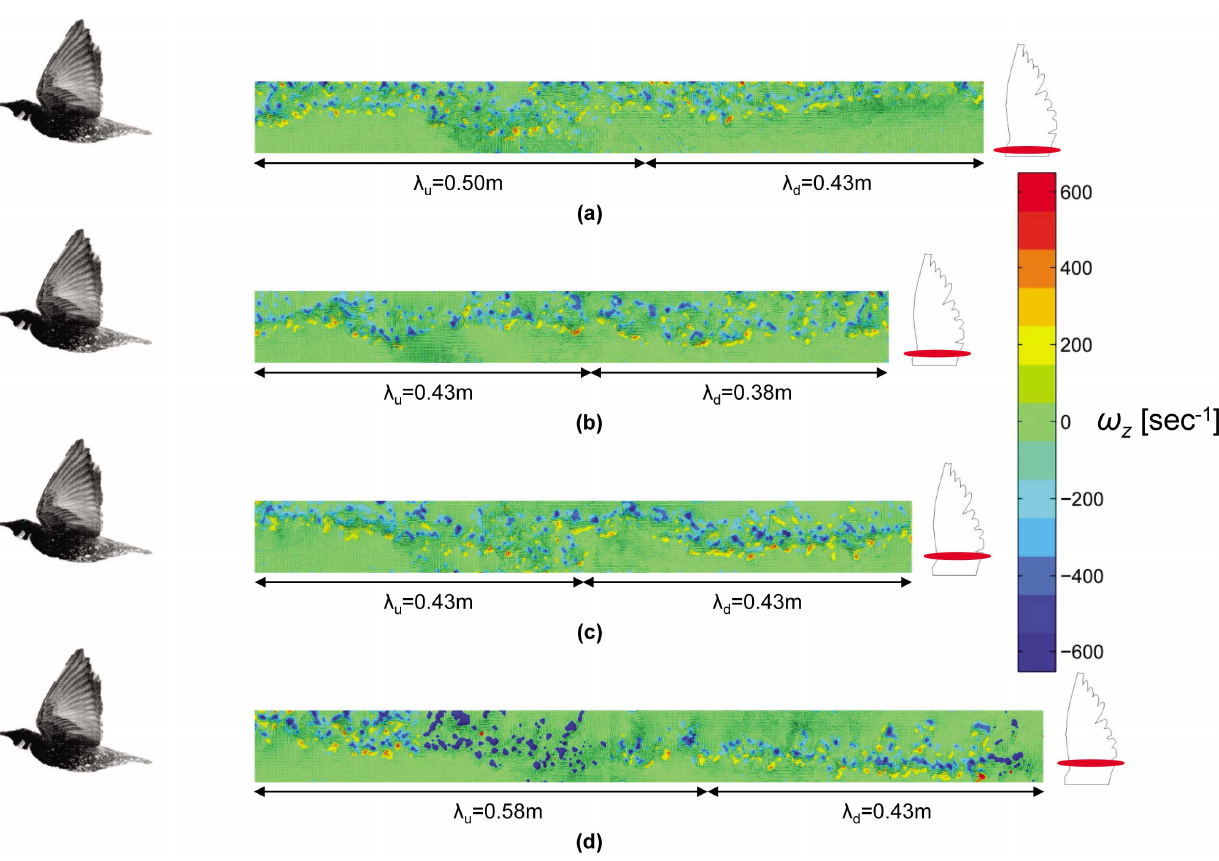
Figure 8. Reconstruction of the starling’s wake consisting of four wingbeats as though the starling flew from right to left. The average spatial flow has been subtracted, thus the vectors displayed are the velocity fluctuations. The contours represent the spanwise vorticity in each wingbeat and the half-wavelengths for the downstroke ( l d ) and the upstroke ( l u ) are noted for each wingbeat. Wingbeat numbers go from top to bottom: (a) 1, (b) 2, (c) 3, and (d) 4.